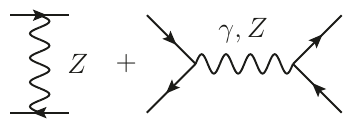
Figure 7 . Contributions to the 1 =m 2